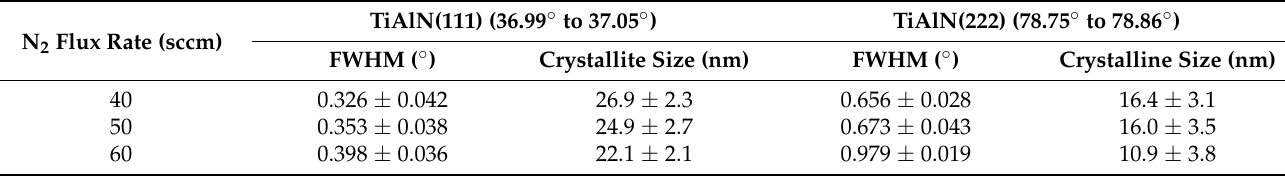
Table 2. FWHM and crystallite size of the TiAlN